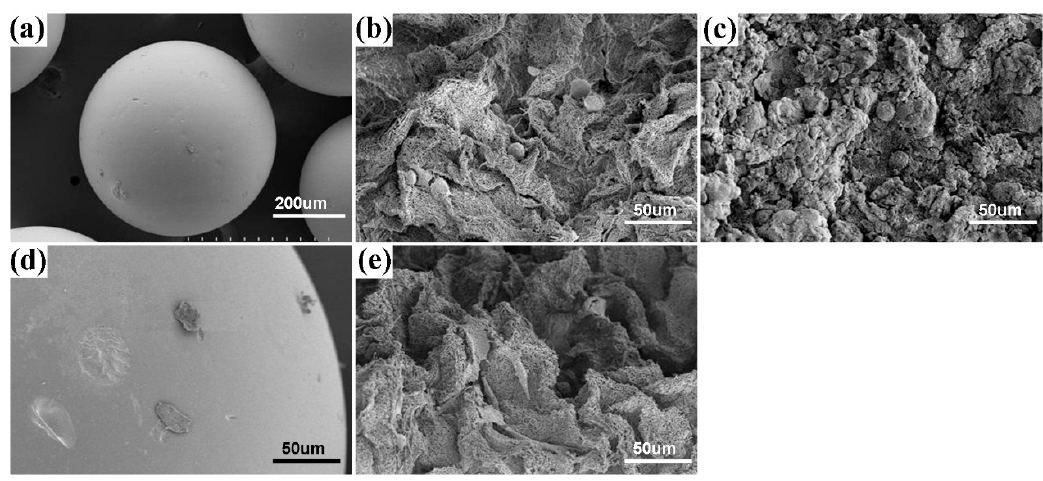
Figure 8. Representative images of the MG63 osteoblast-like cells cultured on microbeads for 1 and 3 d. ( a , d ) GBs; ( b , e ) MFBs; ( c ) MBs; ( a – c ) 1 day; ( d , e ) 3 days.